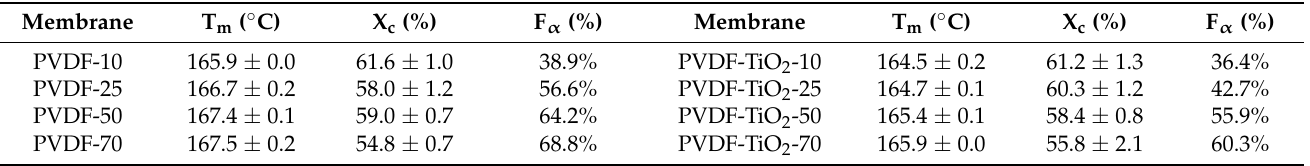
Table 2. Melting temperature (T m ), total crystallinity (X c ) and fraction of α crystalline form (F α ) of membranes (the number after membrane name indicates the temperature ( ◦ C) at which it was